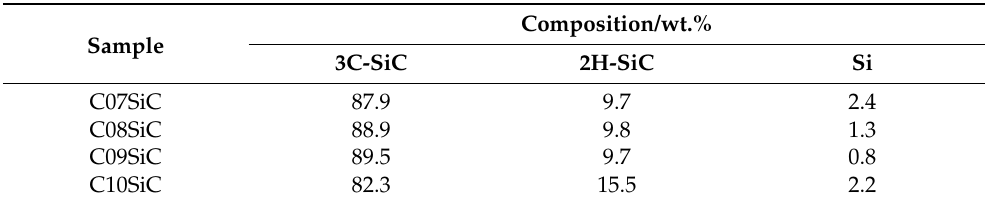
Table 7. Composition of the calcined product at 700 ◦ C in an air atmosphere after washing with a mixture of HF and CH 3 COOH